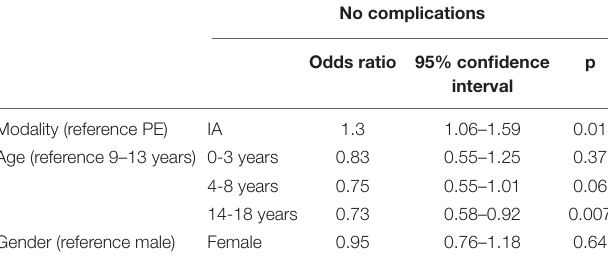
TABLE 6 | Multivariate analysis of occurrence of complications.